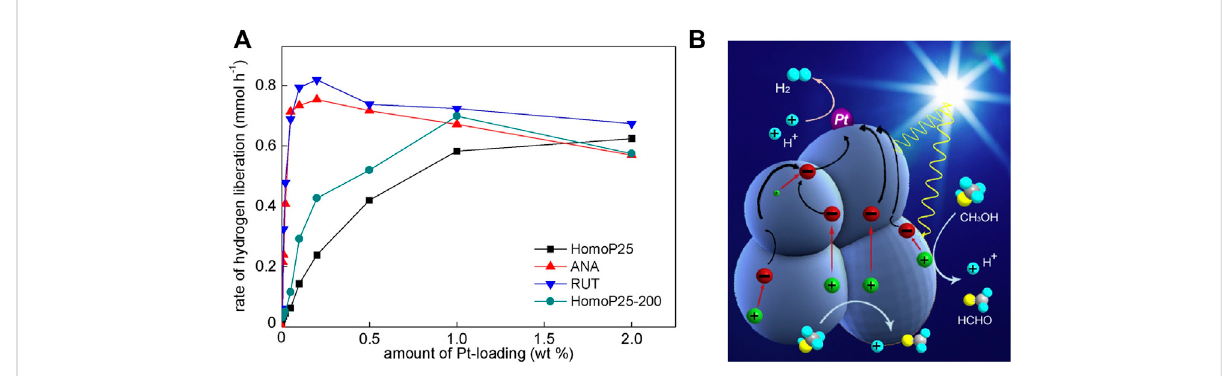
FIGURE 6 (A) The in fl uence of platinum content on the photocatalytic activity during methanol dehydrogenation; (B) the schematic image showing the IPET in aggregated single-phase titania particles. Adapted from (Wang et al., 2018) with permission from